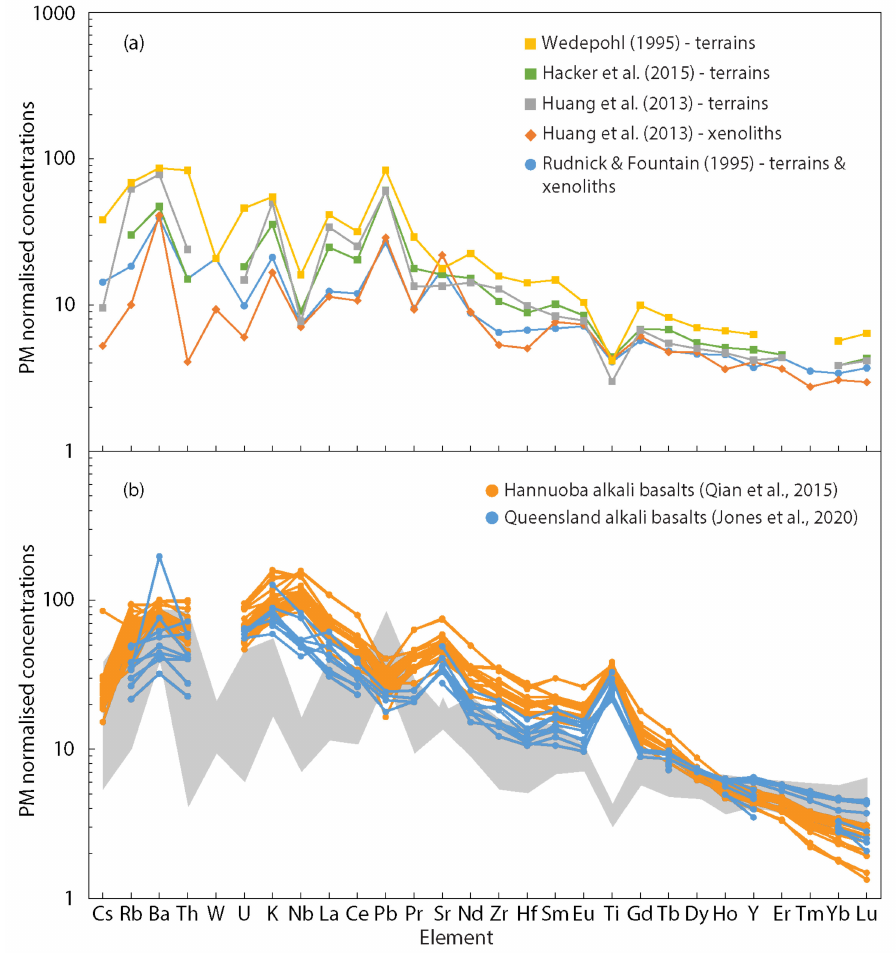
Figure 1. Primitive mantle (PM)-normalized [19] extended trace element plots for ( a ) published compositional estimates of the lower continental crust. The xenolith and terrain estimates of Huang et al. [5] uses median values from their database; ( b ) alkali basalt samples from the Hannuoba volcanic province [20], a xenolith-bearing province in the North China Craton, and xenolith-bearing Cenozoic volcanic provinces of eastern Queensland, Australia [21]. The range of lower crustal compositions from ( a ) is shown in